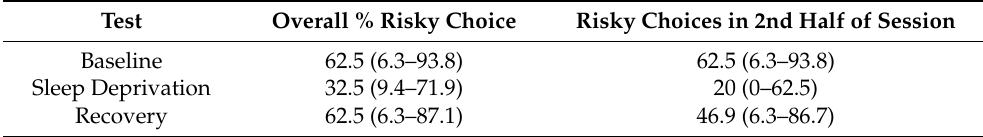
Table 3. Median (minimum–maximum) risk preference in the sleep deprivation condition.